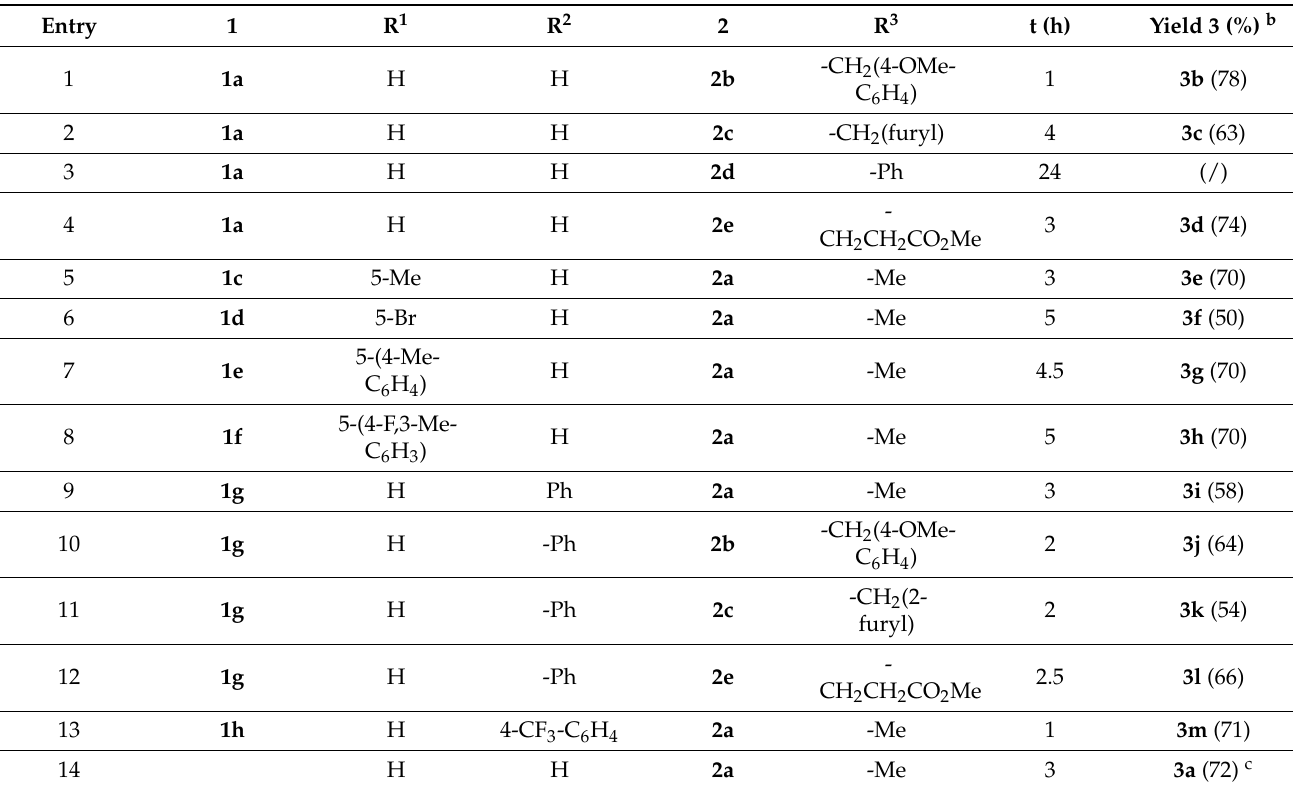
Table 2. Synthesis of 2-substituted 1,2-dihydro-3 H -pyrrolo[1,2- a ]indol-3-one 3 from indol-2- Table 2. Cont .